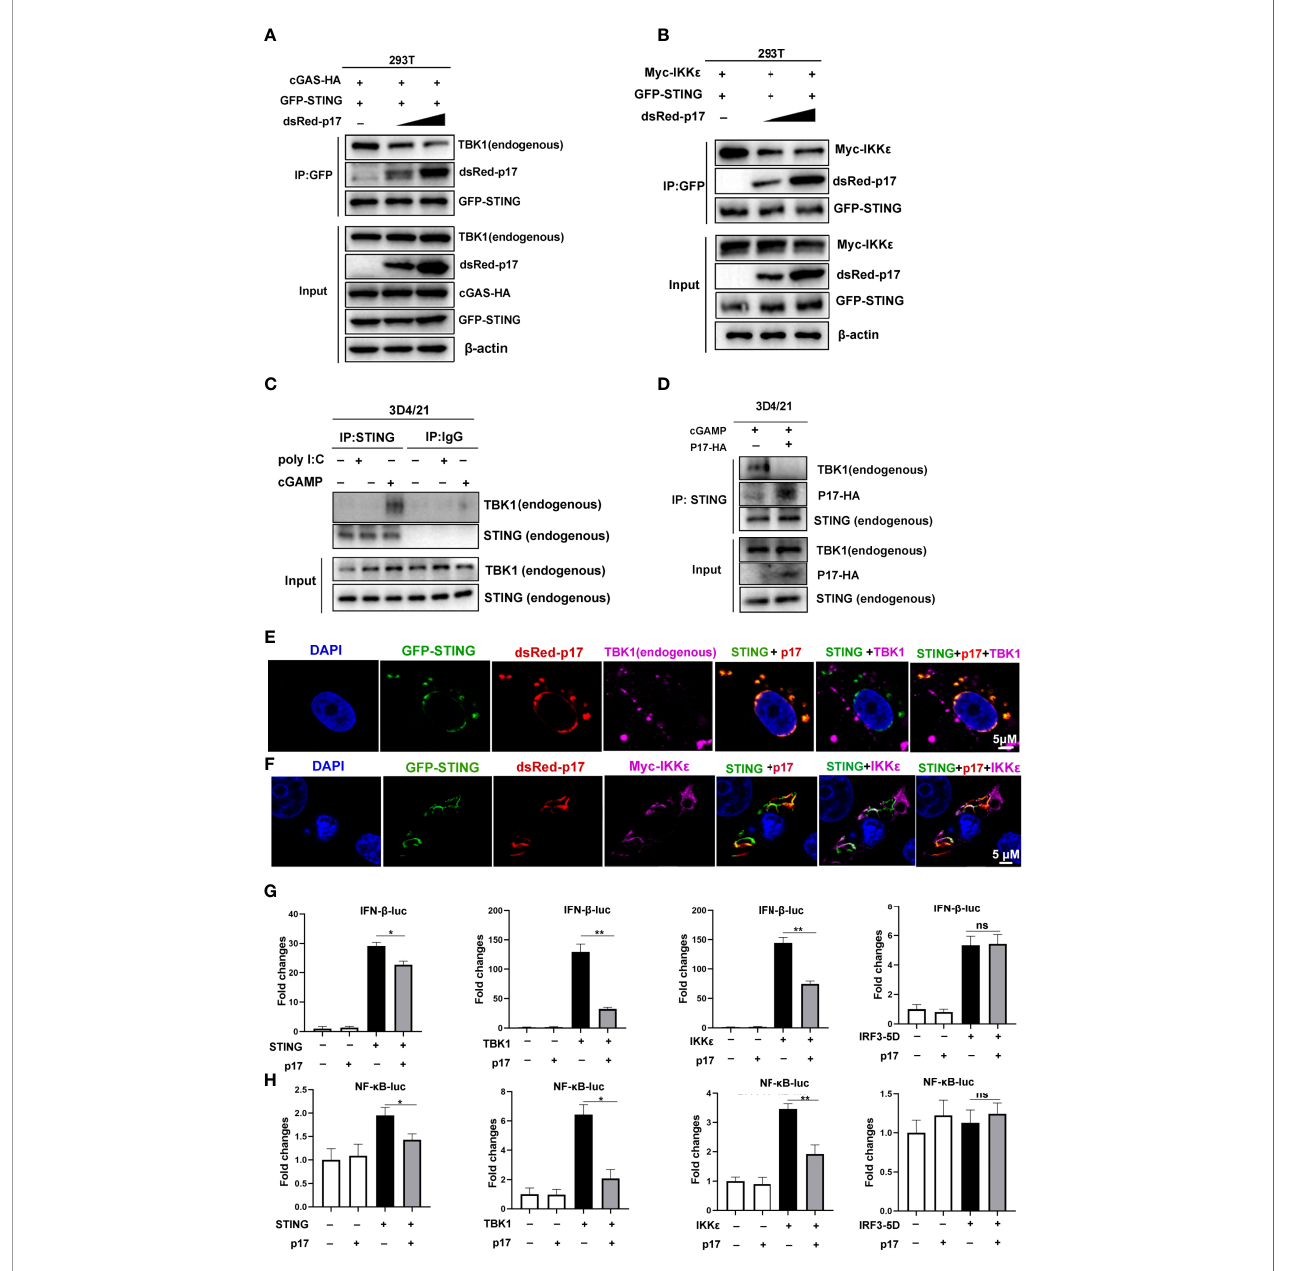
FIGURE 6 | (A, B) The effects of p17 on the interactions and cellular co-localizations between STING and TBK1/IKK ϵ . (A) 293T cells in 6-well plate were co- transfected with pcGAS-HA (0.5 m g) and pGFP-STING (0.5 m g) with or without pdsRed-p17 (0.5 m g and 1 m g) for 24 h (B) 293T cells were co-transfected with pGFP-STING (0.5 m g) and pMyc-IKK ϵ (0.5 m g) with or without pdsRed-p17 (0.5 m g and 1 m g) for 24 (h) The cell lysates were subjected for immuno-precipitation and Western blotting using the indicated antibodies. (C, D) The effect of p17 on the interaction between endogenous STING and TBK1. (C) 3D4/21 cells were stimulated by transfection of poly I:C (1 m g/mL) or 2 ’ 3 ’ -cGAMP (1 m g/mL), respectively, for 12h. The cell lysates were subjected for immune-precipitation with rabbit anti-STING pAb, and subsequent Western blotting using the rabbit anti-TBK1 mAb and anti-STING pAb. (D) The pCAGGS-p17-HA (2 m g) were transfected into 3D4/21 cells for 12h and then stimulated by transfection of 2 ’ 3 ’ -cGAMP (1 m g/mL) for another 12h. The cell lysates were subjected for immune-precipitation and subsequent Western blotting. (E, F) The effect of p17 on the cellular co-localization between STING and TBK1/IKK e was analyzed by IFA. GFP and dsRed expression in cells was directly visualized by confocal microscopy. The endogenous TBK1 and Myc-IKK were stained by rabbit anti-TBK1 mAb and anti-Myc, respectively, followed by Alexa Fluor plus 647 anti-rabbit secondary antibody. (G, H) The effects of p17 on the activations of IFN promoter (G) and NF- k B promoter (H) triggered by transfected STING (20 ng), TBK1 (20 ng), IKK ϵ (20 ng) and IRF3-5D (20 ng). The fold changes are relative to vector transfected controls. Values represent the mean±S.D. * P <0.05, ** P <0.01, ns not signi fi